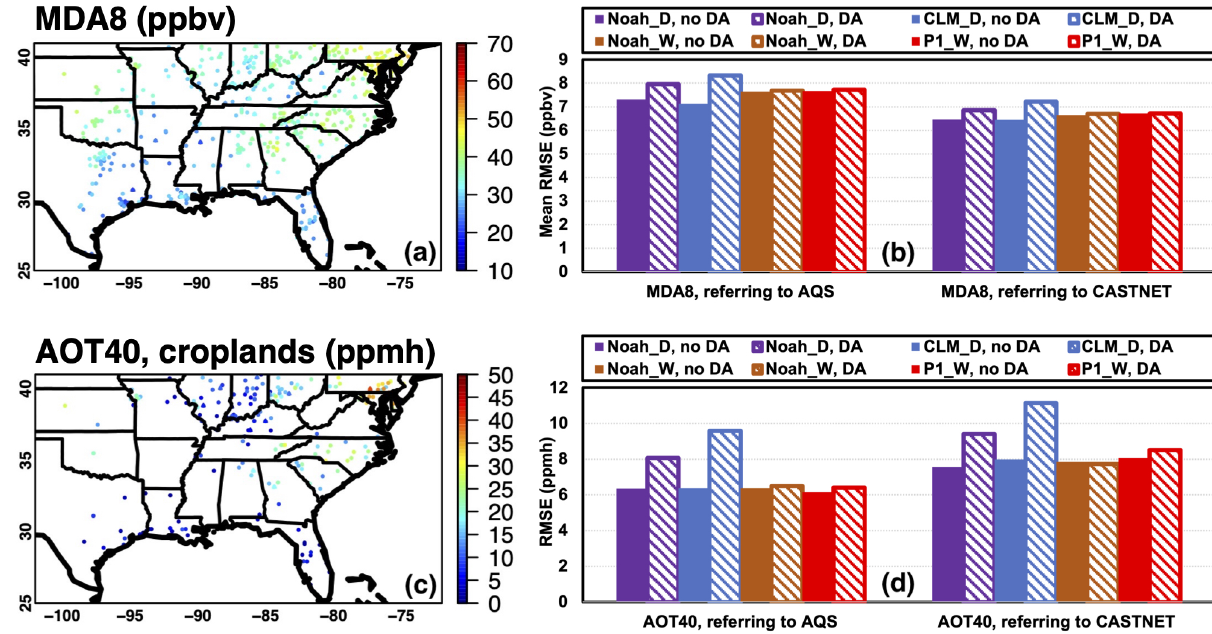
Figure 12. (a) Period-mean (16–28 August 2016) observed surface MDA8 O 3 and (c) AOT40 in cropland-dominant model grids derived from surface observations during 16–28 August 2016. The RMSEs of modeled MDA8 and model-derived AOT40 from various WRF-Chem cases referring to (a) and (c) are summarized in (b) and (d) ,